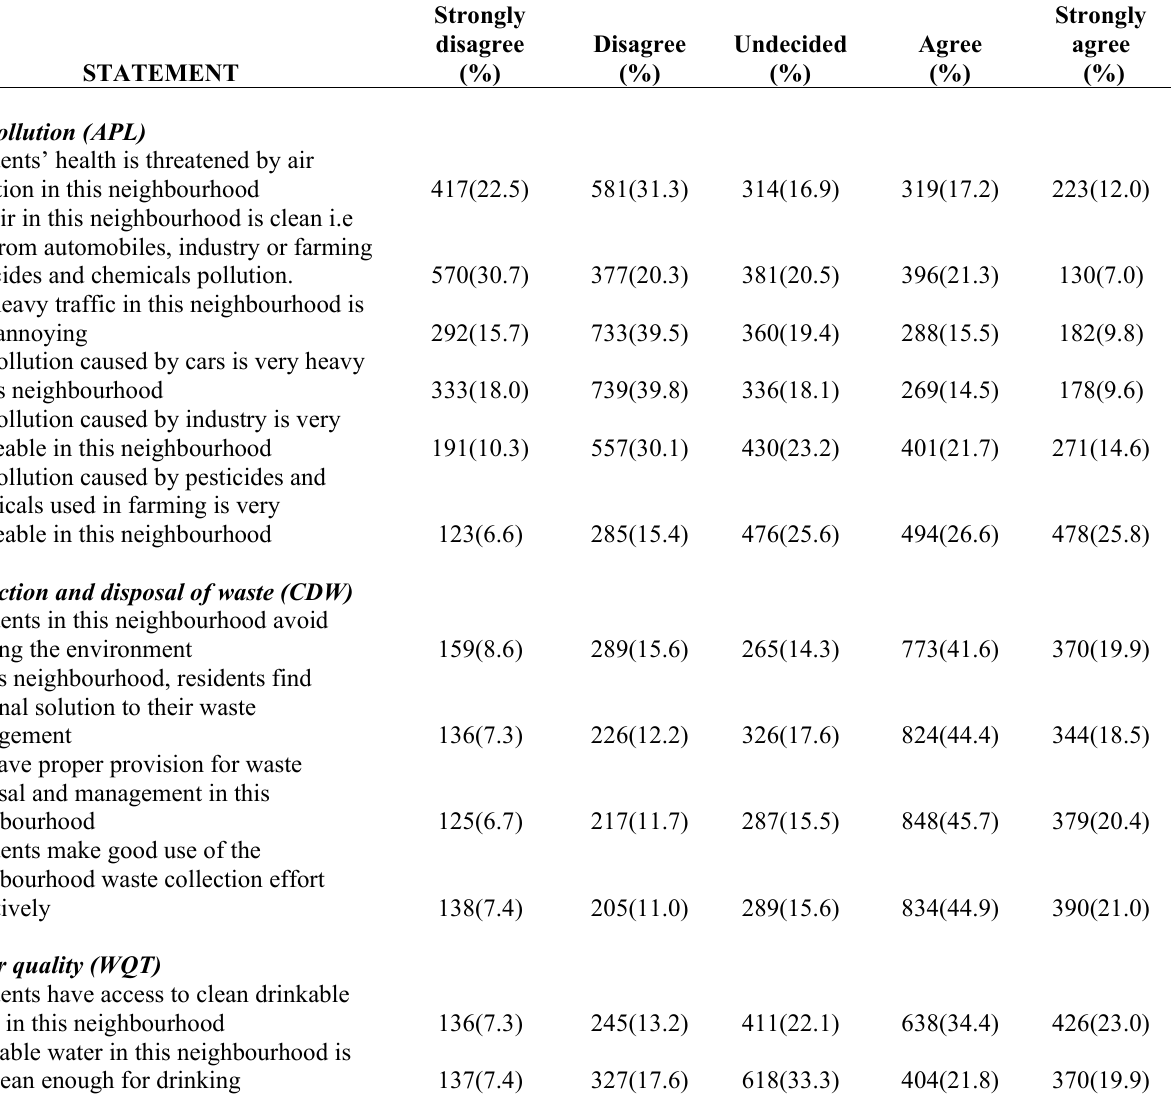
Table S2: General Environmental